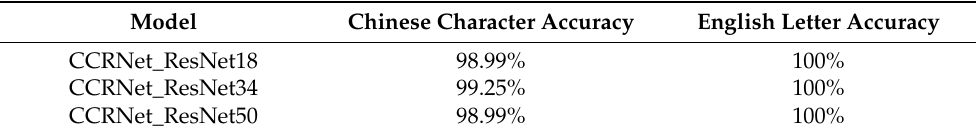
Table 4. The accuracy of CCRNet on Chinese characters and English